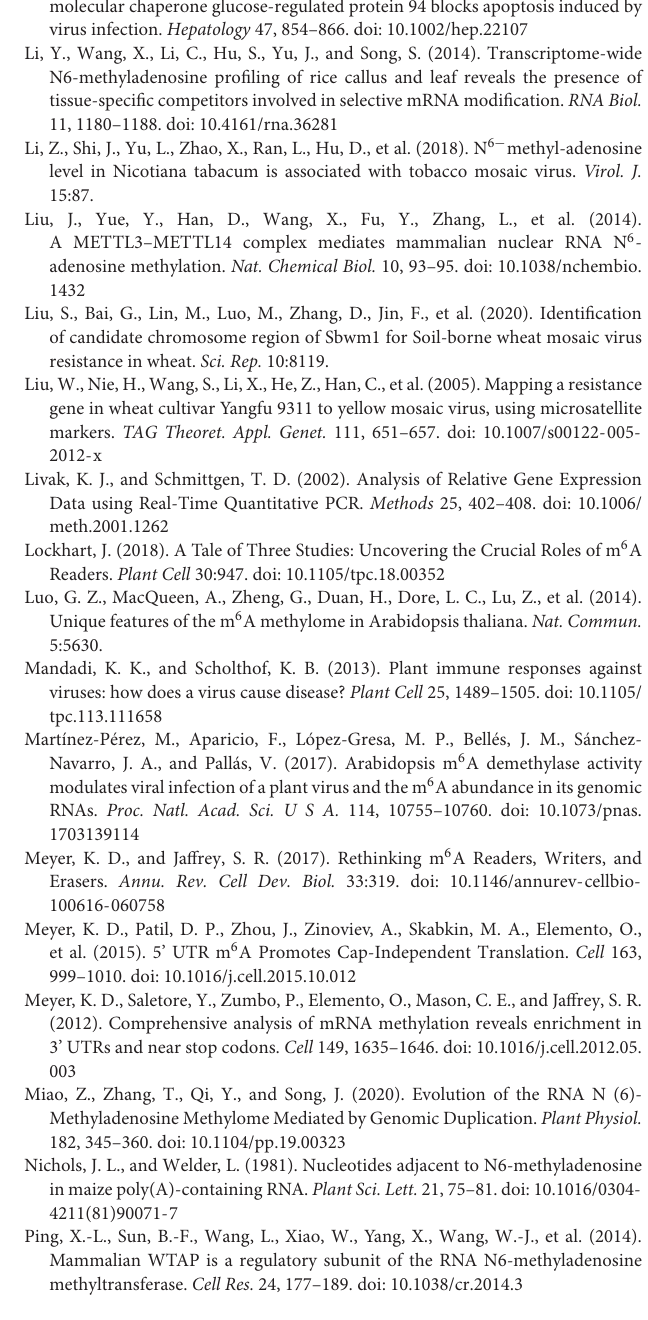
Supplementary Table 1 | Statistics and quality control of raw data generated by sequencing. Supplementary Table 2 | Summary of the RNA-seq and m6A-seq of two variety. Supplementary Table 3 | List of the expressions of key m6A enzymes according to RNA-seq data. Supplementary Table 4 | The sequences of the primers used in these